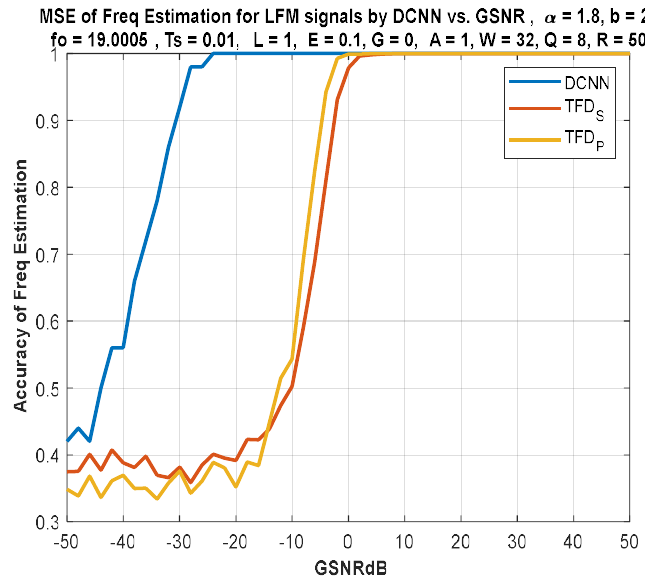
Figure 31. Accuracy of FE for noisy LFM (AWGN and SαSN) by DNN and TFD for spectrogram (TFD s ) and pspectrum (TFD p ).